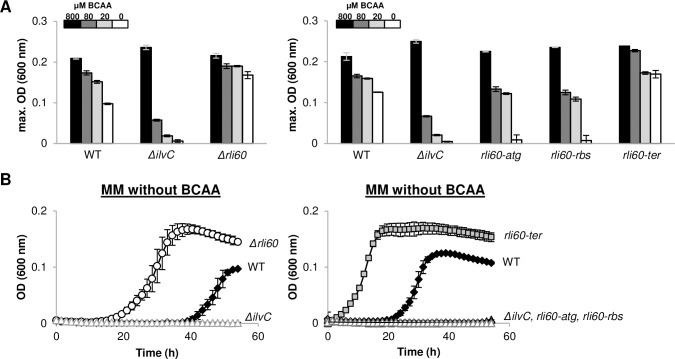
Rli60 mediates Lm’s BCAA partial-auxotrophy.(A) Presentation of maximal OD measurements (600 nm) of WT bacteria and indicated mutants grown in minimal defined medium containing decreasing concentrations of BCAA (800 μM, 80 μM, 20 μM and without a supplement of BCAA). Maximal OD values were extracted from growth analyses presented in Fig 4B and S4 Fig. The data represent 3 biological replicates (N = 3). Error bars represent standard deviation. (B) Growth of WT Lm and indicated mutants in minimal defined medium, which is completely lack of BCAA. Growth was measured by a Synergy HT BioTek plate reader at 37°C for 55 h. The data represent 3 biological replicates (N = 3). Error bars represent standard deviation.